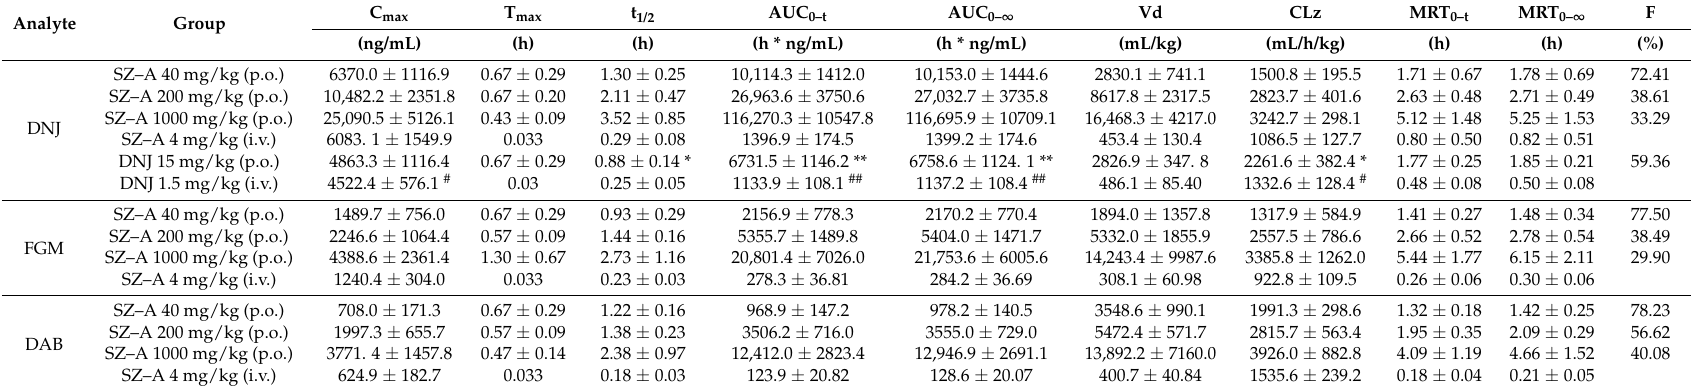
Table 1. Pharmacokinetic parameters of DNJ, FGM, and DAB in rats after oral administration of SZ–A at 40, 200, 1000 mg/kg and intravenous injection of SZ–A at 4 mg/kg ( n =